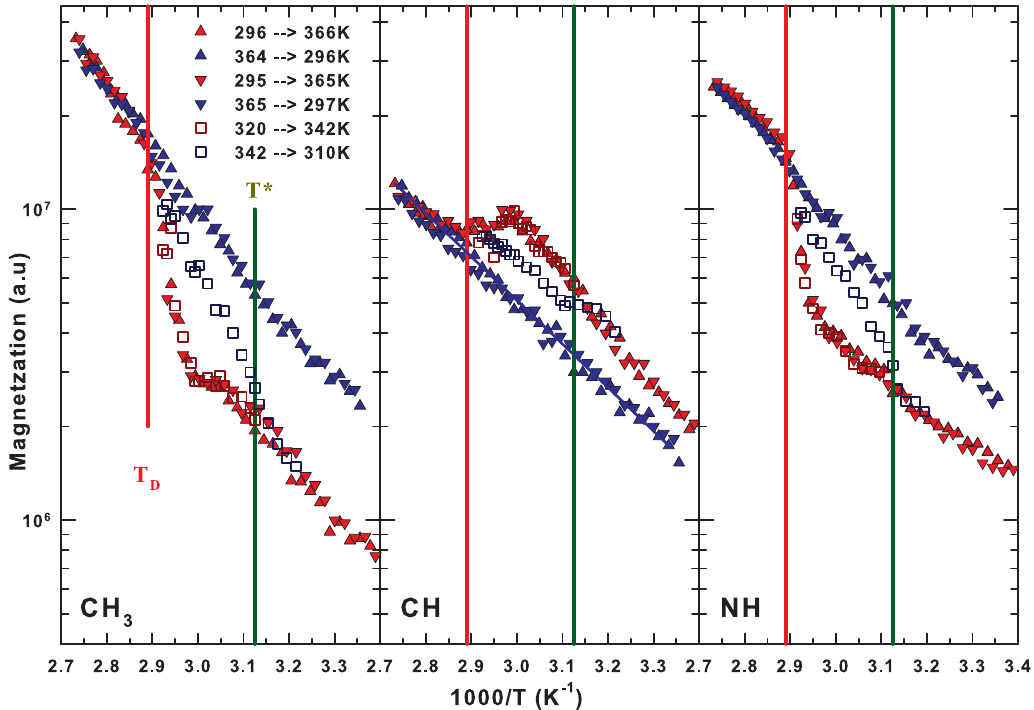
Figure 9. The behavior of the magnetization of the different considered molecular groups during different thermal cycles as a function of the inverse temperature in an Arrhenius fashion. The left panel reports the behavior of the highly hydrophobic methyl group, the central panel that of the methine group, and the right panel that of the hydrophilic secondary amine group. Figure adapted from Reference